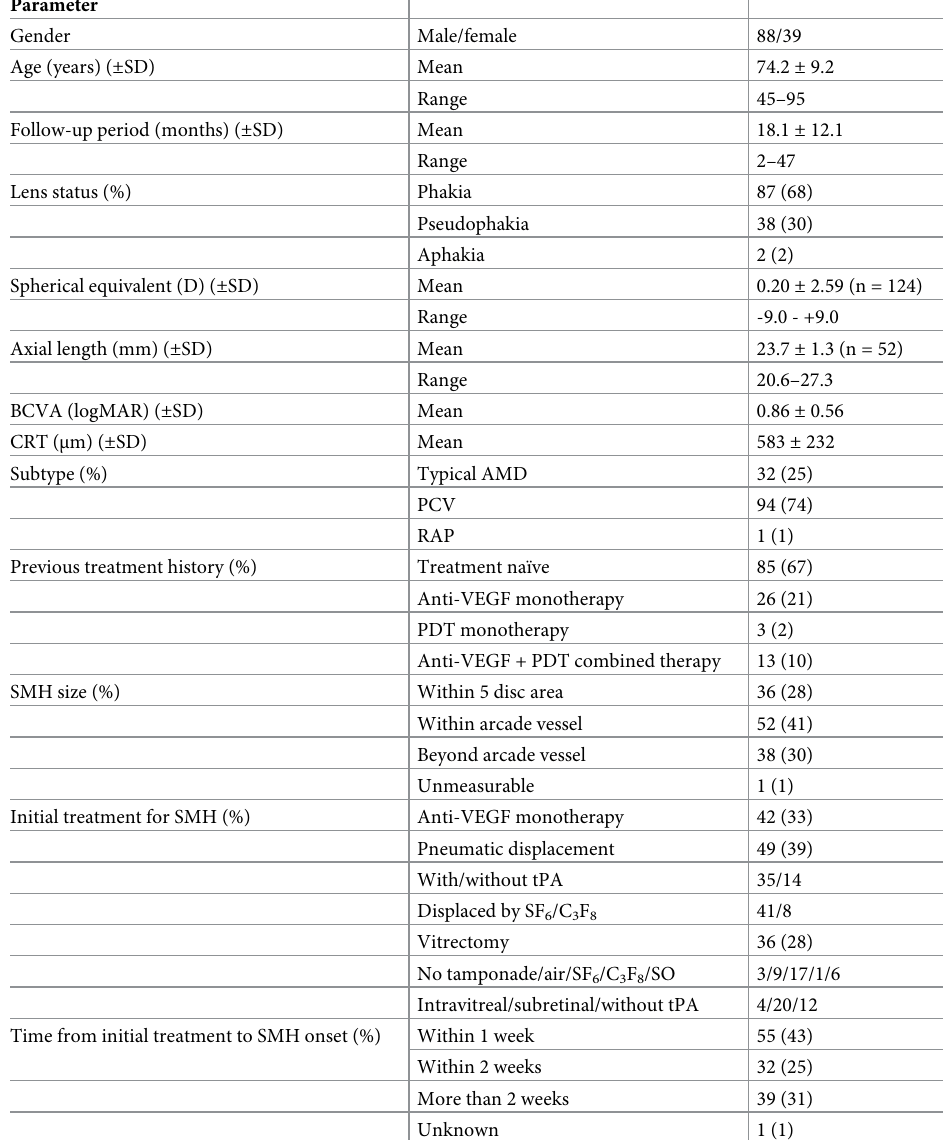
Table 1. Baseline characteristics and initial treatment for SMH of 127 eyes of 127